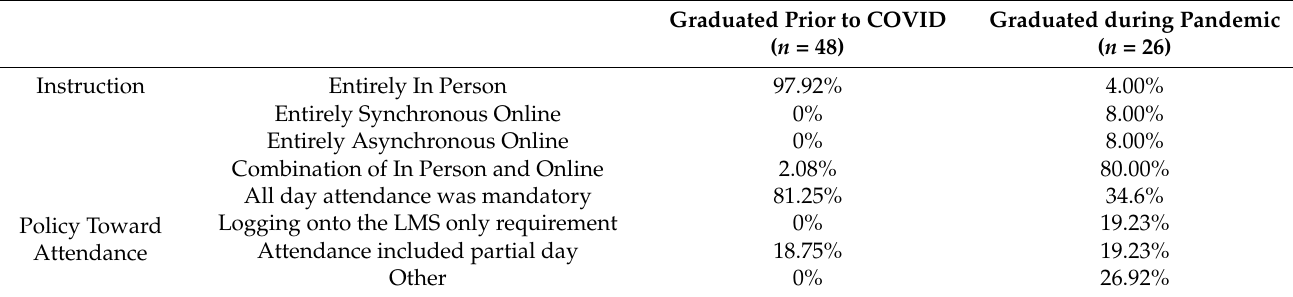
Table 2. High School Experiences Impacted by the